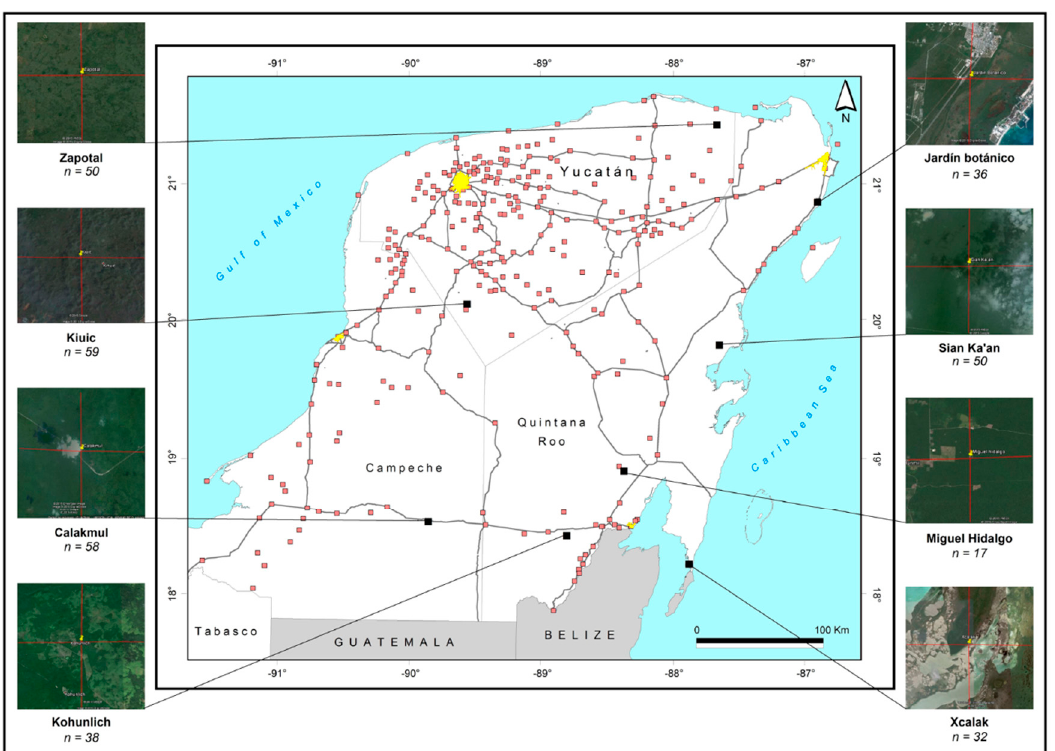
Figure 1. Geographical location of the eight sites in the Yucatan Peninsula (Mexico) where Eunica tatila was collected. For each locality, we present the 16 km 2 square used to characterize the land cover of each area (refer to material and methods for more information). Number of collected individuals (n), principal cities (Chetumal, Cancun, Merida, Campeche) (yellow squares), and cities with more than 1000 inhabitants (red squares).